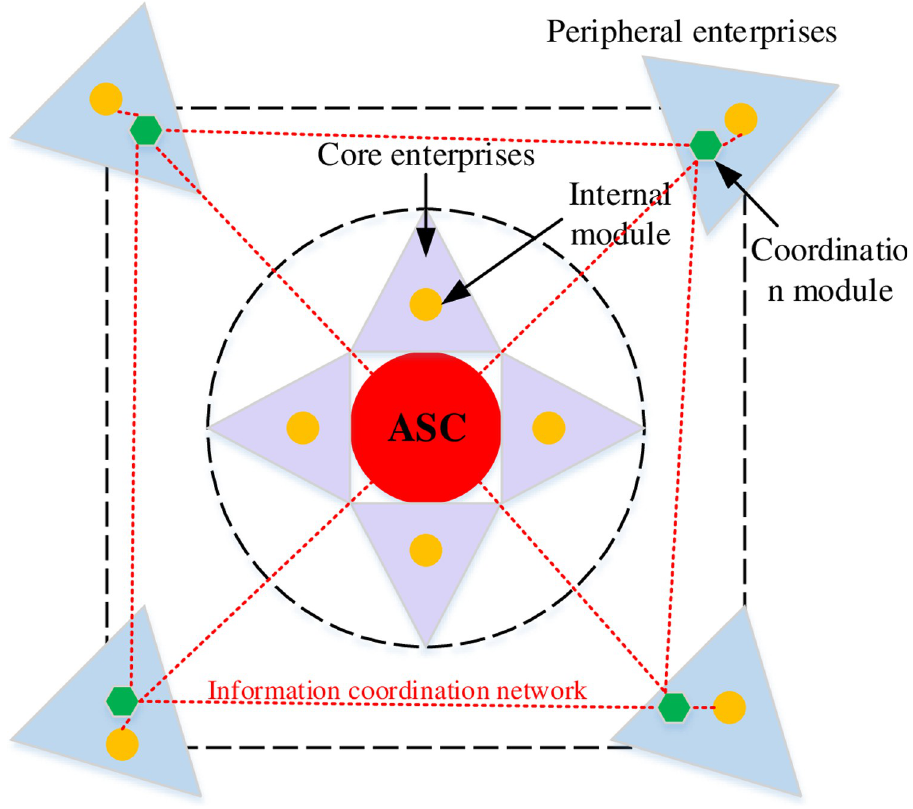
Fig 1. Model diagram of virtual team organization